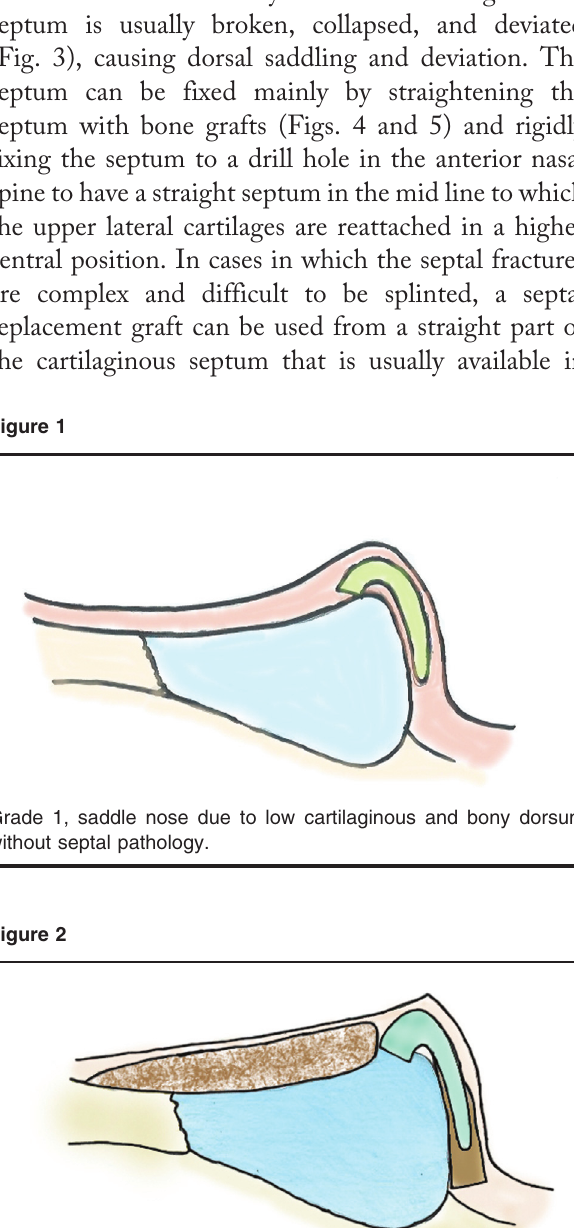
Diced cartilage in fascia and columellar strut for grade 1